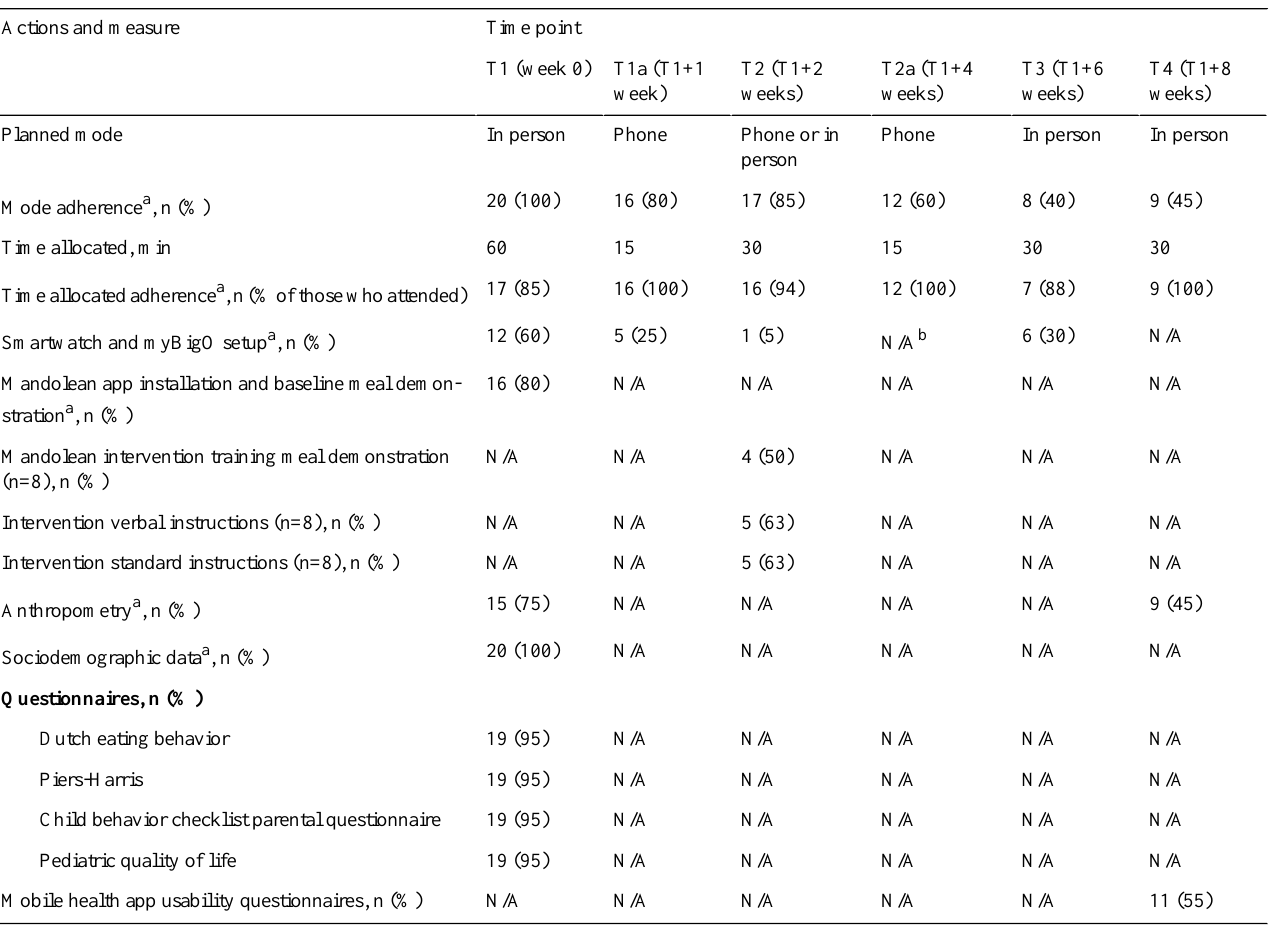
Table 2. Fidelity with planned actions and measures at each time point.